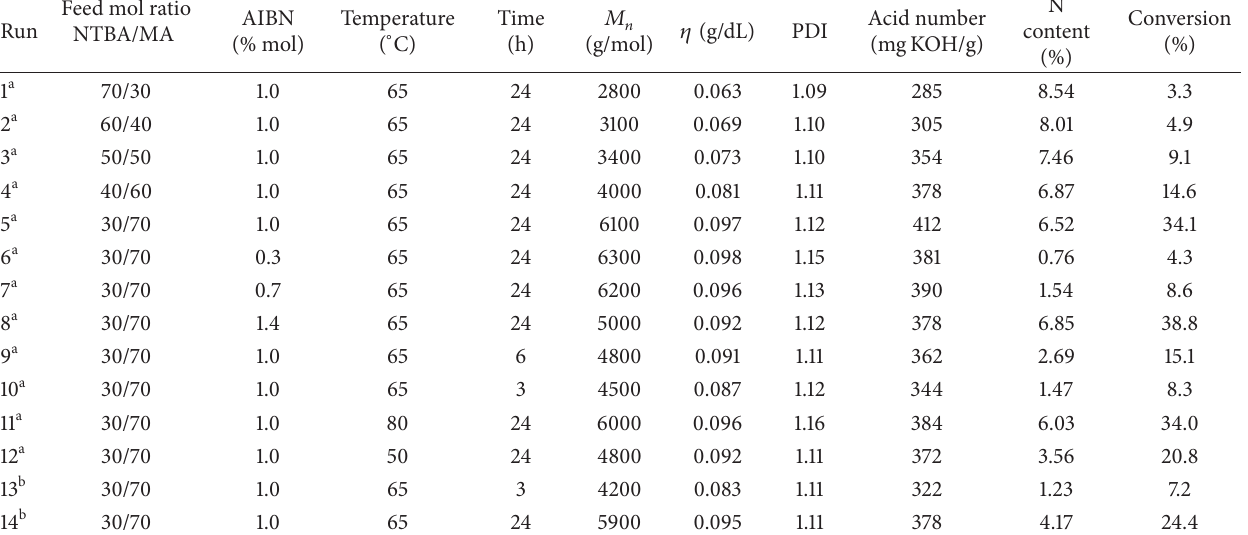
Table 2: The effect on copolymerization of reaction conditions.